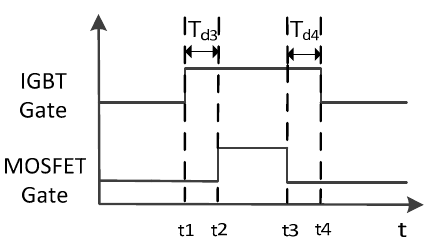
Figure 11. Improved modulation for the hybrid switches.